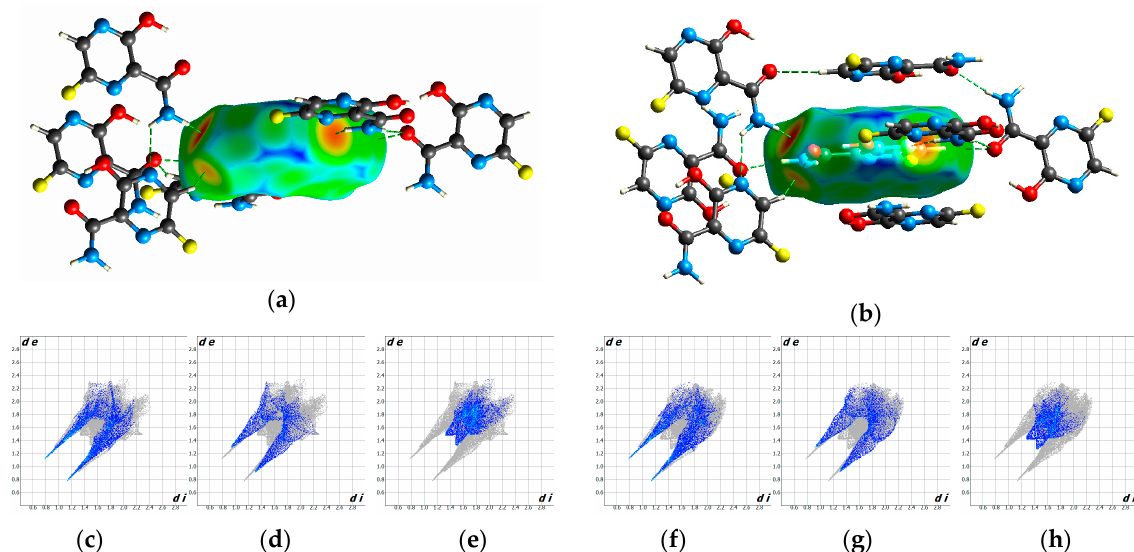
Figure 5. d e plotted on atomic Hirshfeld surface (close contacts are red and elongated are blue) for favipiravir molecule in ( a ) the orthorhomibc polymorph, ( b ) tetragonal polymorph; corresponding fingerprint plots delineated into contribution of O...H, N...H and F...H interactions for the orthorhombic ( c – e ) and the tetragonal ( f – h ) polymorphs. Table 4. Contributions C XY of various types of intermolecular interactions to the molecular Hirshfeld surface of two polymorphs, their R XY values and enrichment ratios E XY . Interaction